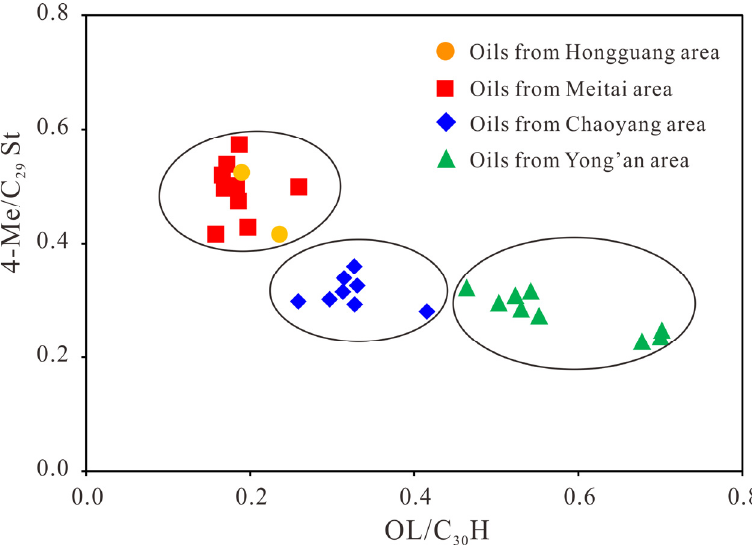
Figure 8. A cross-plot of 4-Me/C 29 sterane (4-Me/C 29 St) vs. oleanane/C 30 hopane (OL/C 30 H) showing the oil family classification in the Huangtong Sag